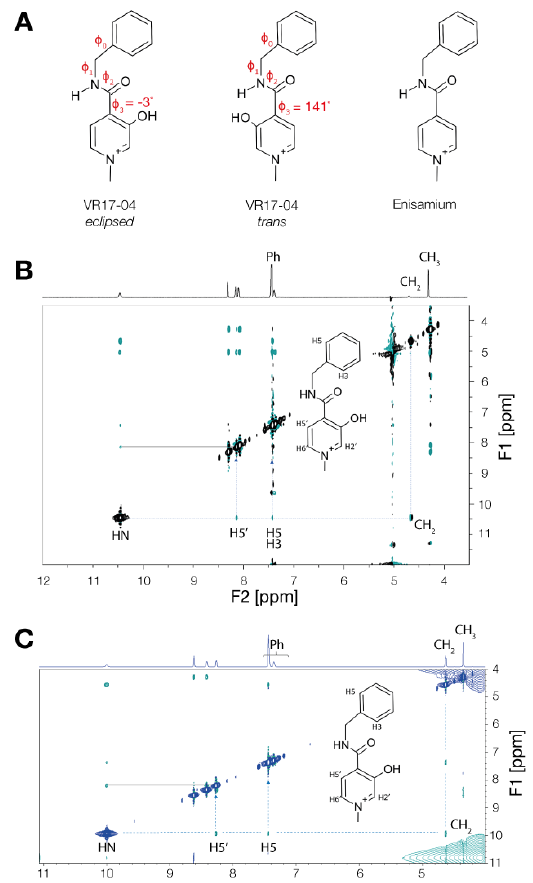
Figure 3. NMR spectrum of enisamium metabolite VR17-04. ( A ) Schematic of the trans and eclipsed conformations of VR17-04. Dihedral angles are indicated with φ . ( B ) 2D-NOESY and 1 H proton spectra of VR17-04 acquired at 277 K in water. The NOE correlation between the HN and H5 ′ proton is highlighted with a dashed line. ( C ) 2D-NOESY and 1 H proton spectra of VR17-04 acquired at 277 K in DMSO. The NOE correlation between the HN and H5 ′ proton is highlighted as in panel B.